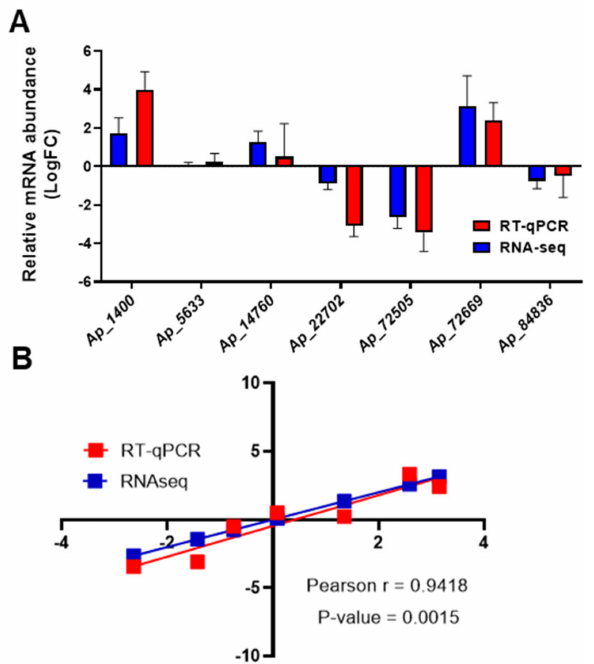
Figure 3. Validation of transcriptome sequencing. ( A ) Experimental validation of RNA-seq results for 7 DE transcripts through RT-qPCR (quantitative reverse-transcription polymerase chain reaction). Ap_1400 : Putative RNA recognition motif domain-containing protein; Ap_5633 : Chromomethylase (CMT); Ap_14760 : Asparagine synthetase; Ap_22720 : SANT domain-containing protein; Ap_72505 : Ribulose bisphosphate carboxylase (RuBisCO) small subunit; Ap_72669: Red chlorophyll catabolite reductase; Ap_84836 : Cytochrome P450 CYP720B12v2. Red and blue columns correspond to transcript abundance quantified by RT-qPCR and RNA-seq, respectively. ( B ) Gene expression correlation between RT-qPCR and RNA-seq data. Pearson r: Pearson correlation